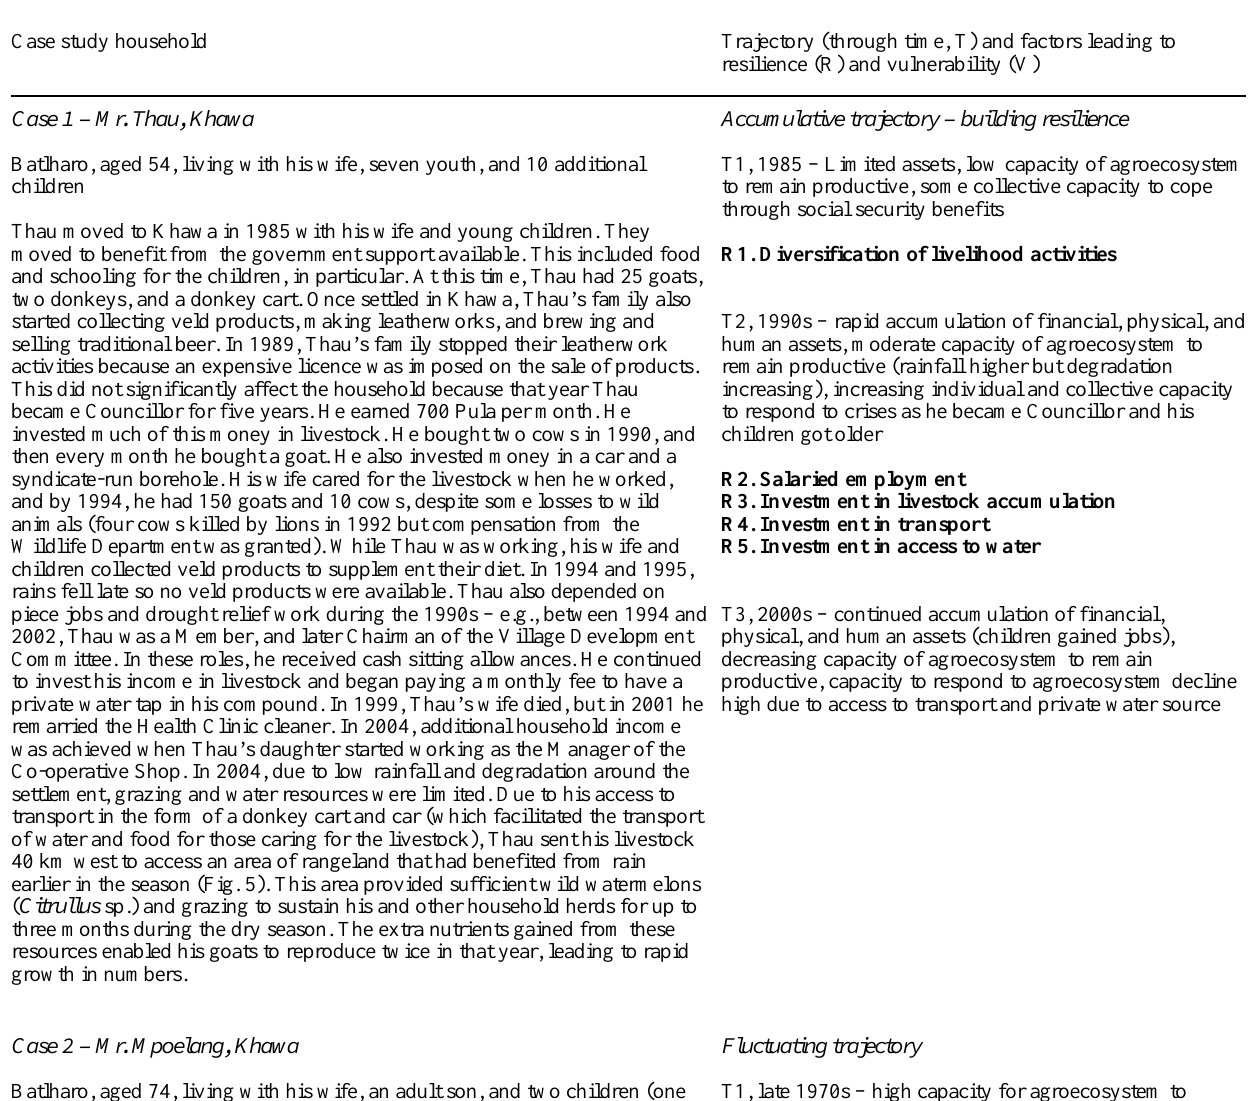
Table 4 . Livelihood dynamics and trajectories of example case study